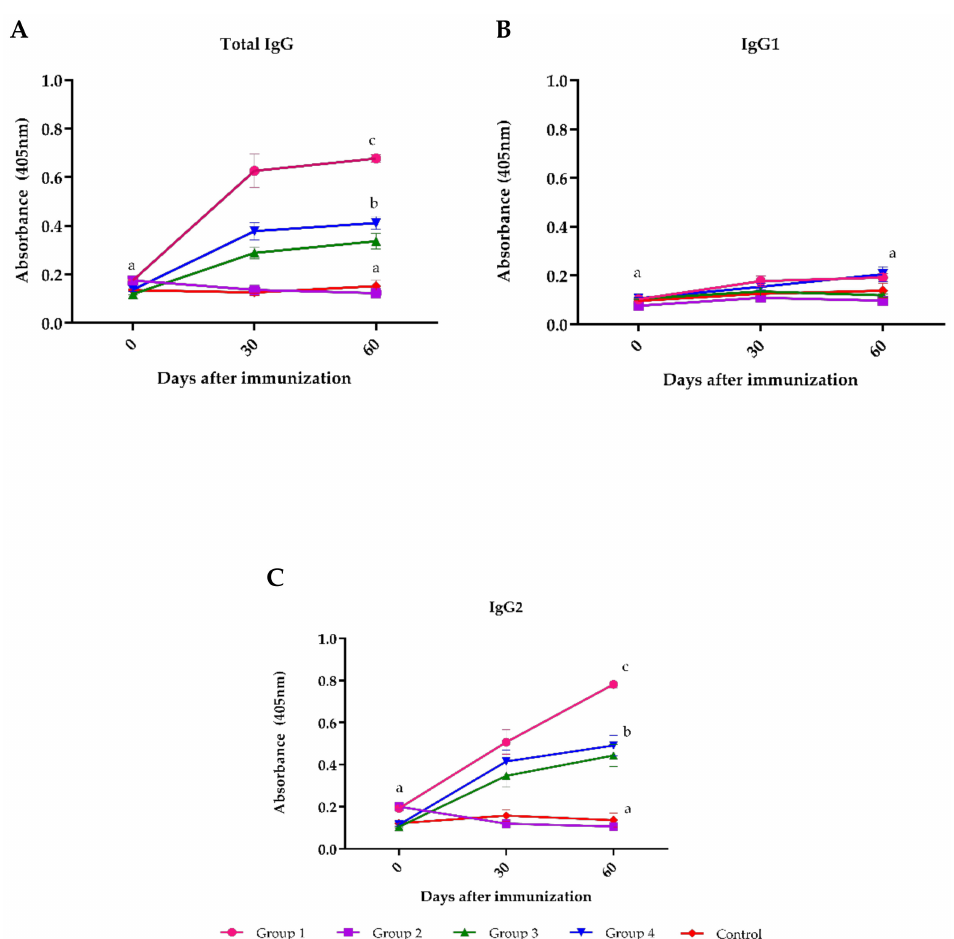
Figure 1. Antibodies to BoHV-1 evaluated by ELISA in sera of cattle immunized with four commercial BoHV-1 vaccines. Group 1 = vaccine A; group 2 = vaccine B; group 3 = vaccine C; group 4 = vaccine D; and Control group (not vaccinated). Mean titers ± standard errors (SEM) are depicted. Letters (a, b and c) highlight significant differences ( p < 0.05) between groups. A : Total IgG antibodies. B : IgG1 subclass antibodies. C : IgG2 subclass